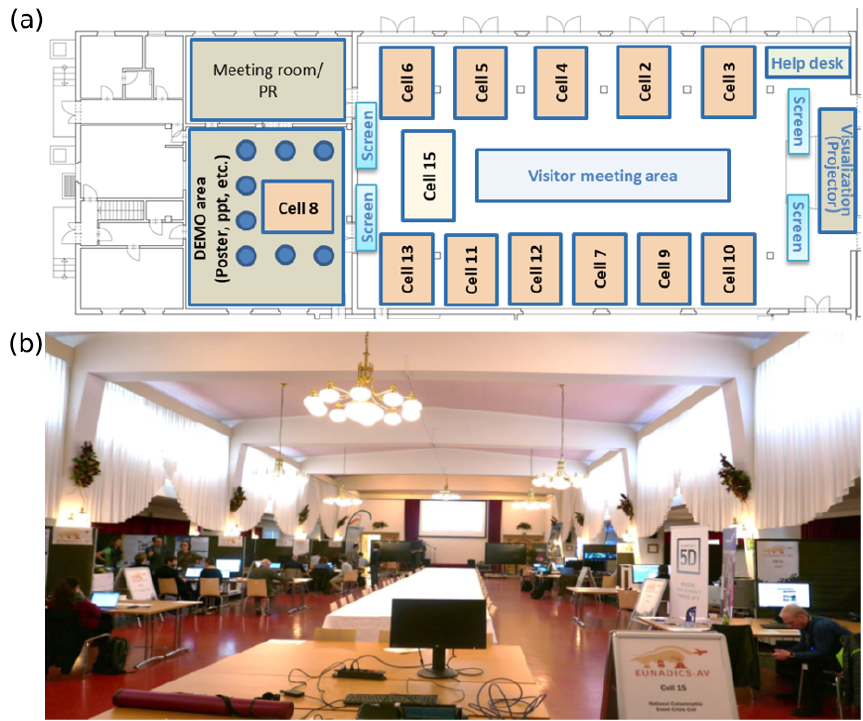
Figure 1. (a) Floor plan of different cells at Schwarzenberg barracks (Salzburg, Austria). (b) Picture of the main hall of the demonstration exercise premises.